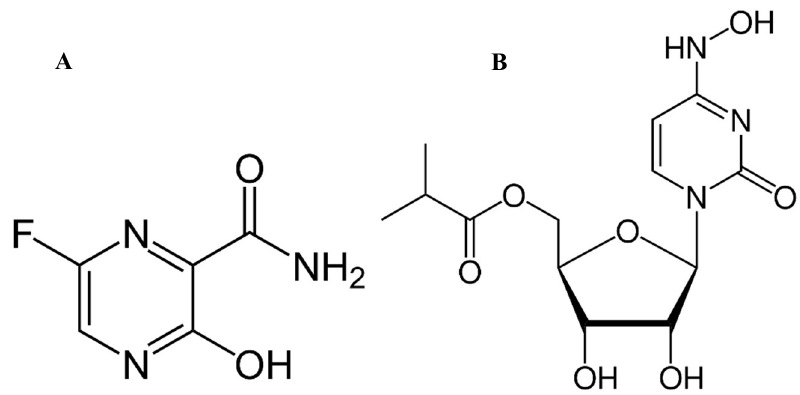
Figure 1. Chemical Structures of ( A ) FAV and ( B ) MLP.